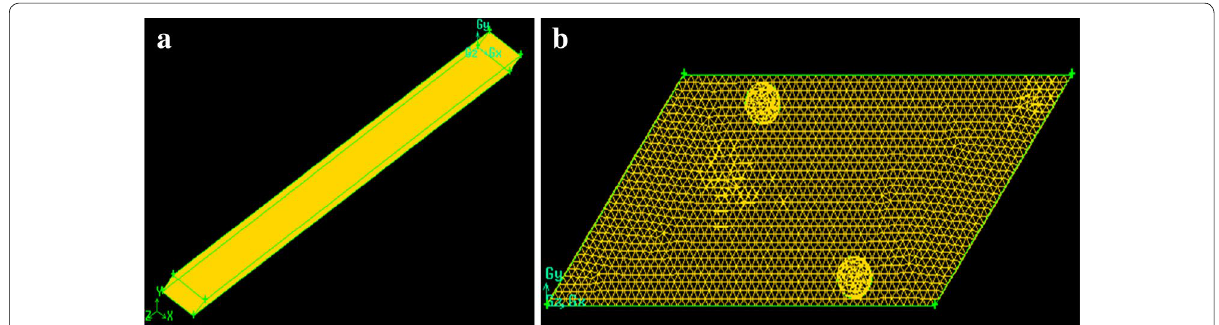
Fig. 2 a Computational domain and b cross‑sectional plane of a microchannel with a parallelogram profile of AR